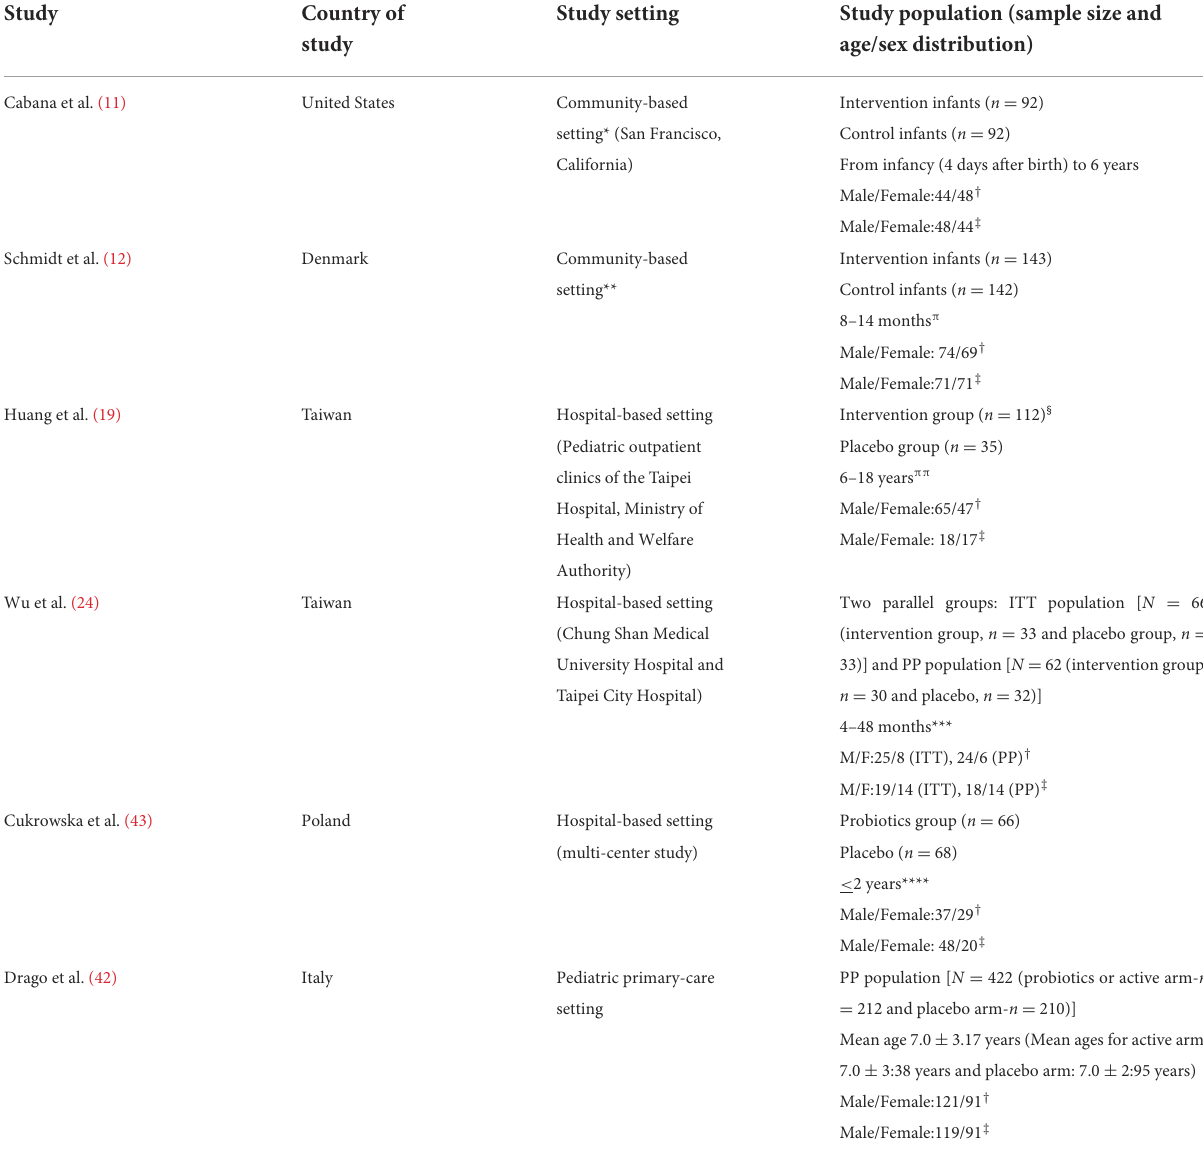
TABLE 1 Characteristics of the randomized controlled trials on probiotic administration for prevention or treatment-optimization of asthma and atopic diseases. Study